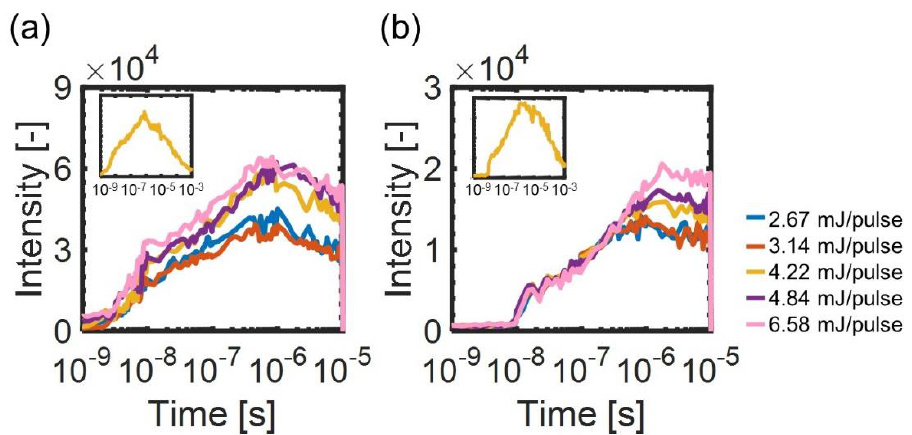
Figure 3. The temporal changes of the stripe amplitudes of the refractive index images for different intensities of the pump light: ( a ) ∆ n e ( t ) ( b ) ∆ n o ( t ) responses. The pump light intensities were 2.67, 3.14, 4.22, 4.84, and 6.58 mJ/pulse. The insets show temporal changes until a millisecond at a pump intensity of 4.22 mJ/cm 2 . The time axis is shown in a logarithmic timescale.